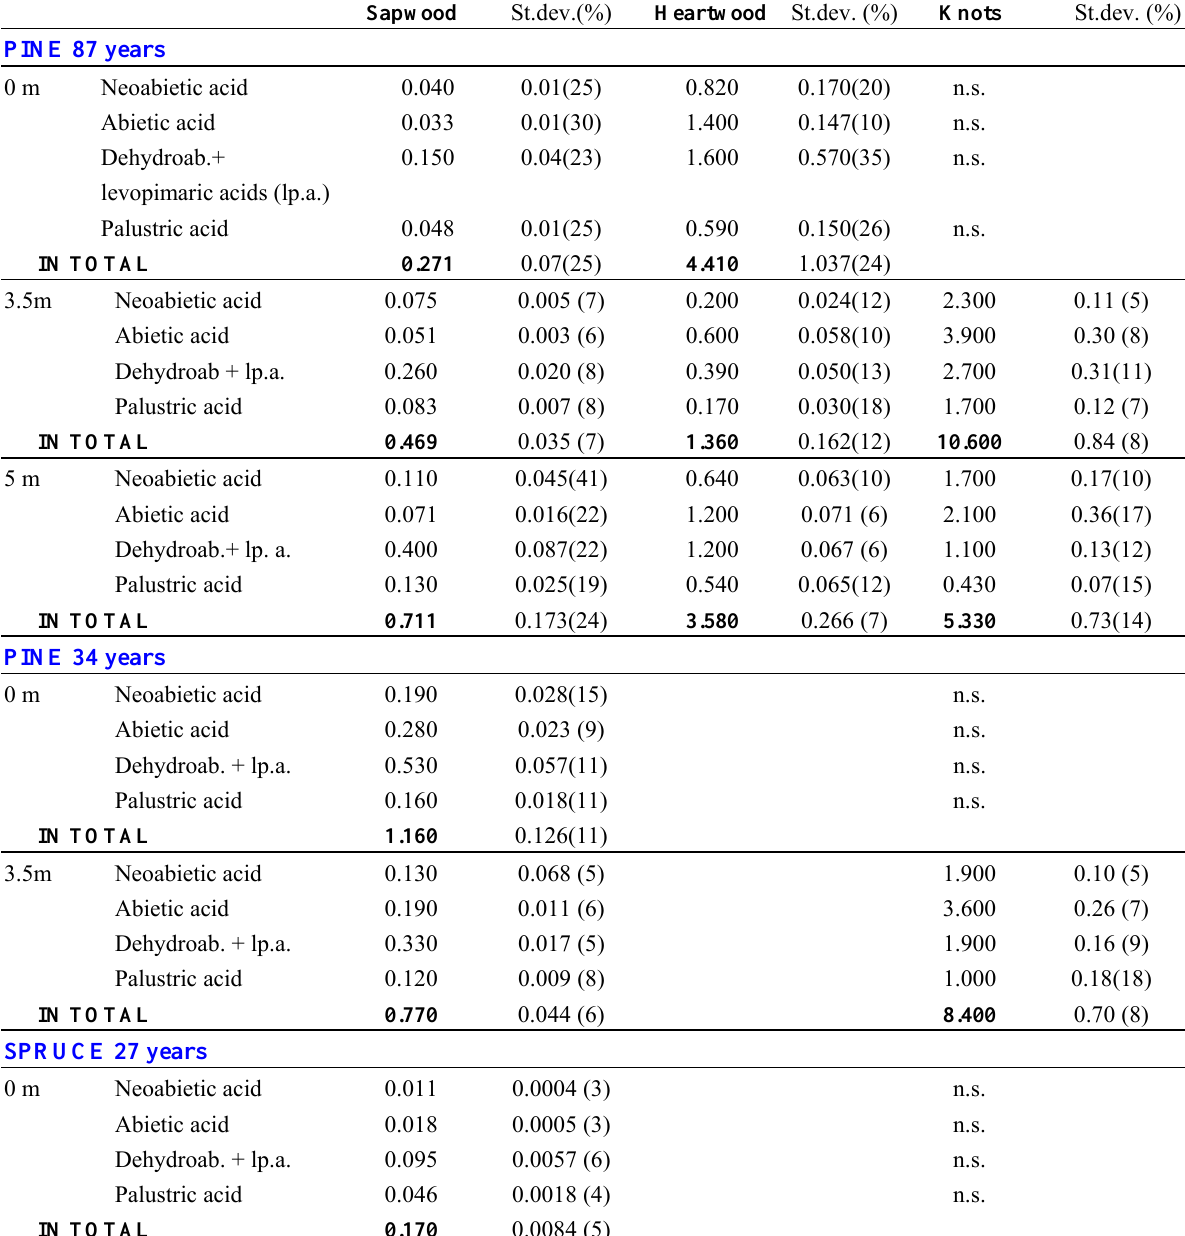
Table 2. Resin acid analyses of Norwegian pine and spruce (see Figure 2); content (%, w/w) and distribution (% of total) a. . St.dev.(%) Heartwood St.dev.